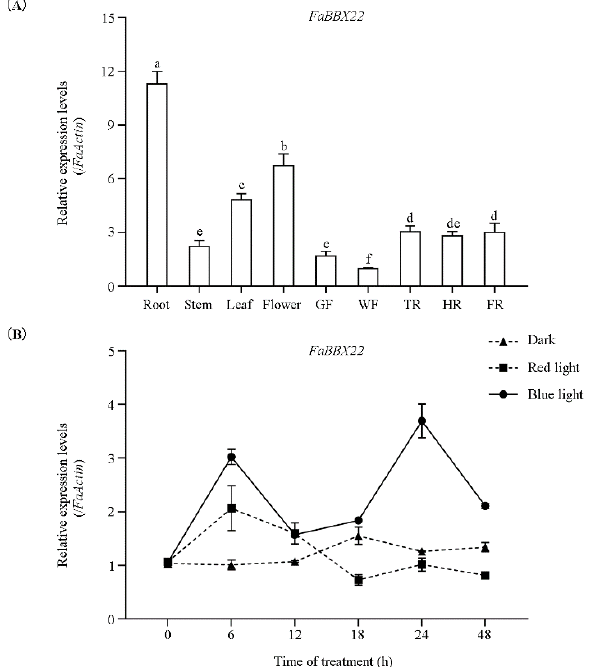
Figure 2. The expression pattern of FaBBX22 . ( A ) The relative expression levels of FaBBX22 in different tissues and fruit development stages. GF, green fruit; WF, white fruit; TR, turn red; HR, half fruit; FR, full fruit; ( B ) The relative expression levels of FaBBX22 during red and blue light irradiation treatments. Error bars represent three independent replicates. Different letters above the bars indicate significantly different values ( p < 0.05) according to a Least Significant Difference (LSD) test.